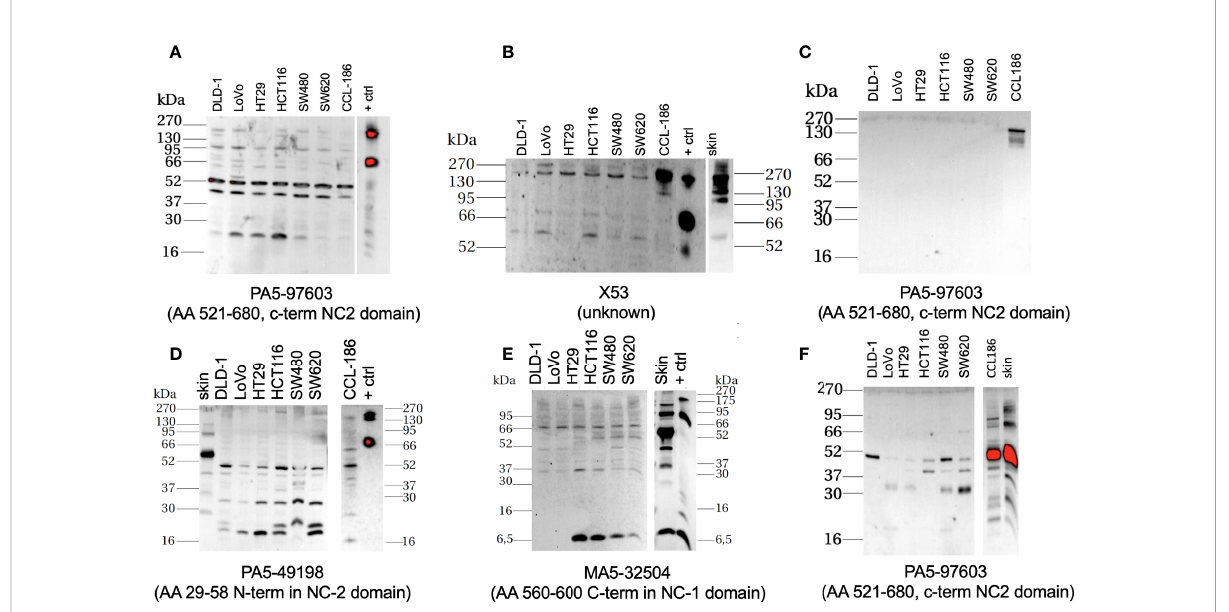
FIGURE 7 Western-blot-based assessment of COL10A1 with four different antibodies (antibody with its putative binding target labeled below the individual membranes, all Thermo Fisher) in extracts from classical CRC cell lines, fi broblast cell line, and skin. Little to low expression of the protein in cancer cells, elevated levels can be detected in the protein lysates and supernatants retrieved from fi broblasts/skin; positive control (+ ctrl) is puri fi ed recombinant protein from COL10A1 overexpressing HEK2973 T cells, housekeeping protein: GAPDH, antibody MA5-15738 (Thermo Fisher). (A, B, D, E) Cell lysates; (C) supernatants 20× concentrated by ultra fi ltration, and (F) supernatants 70× concentrated by